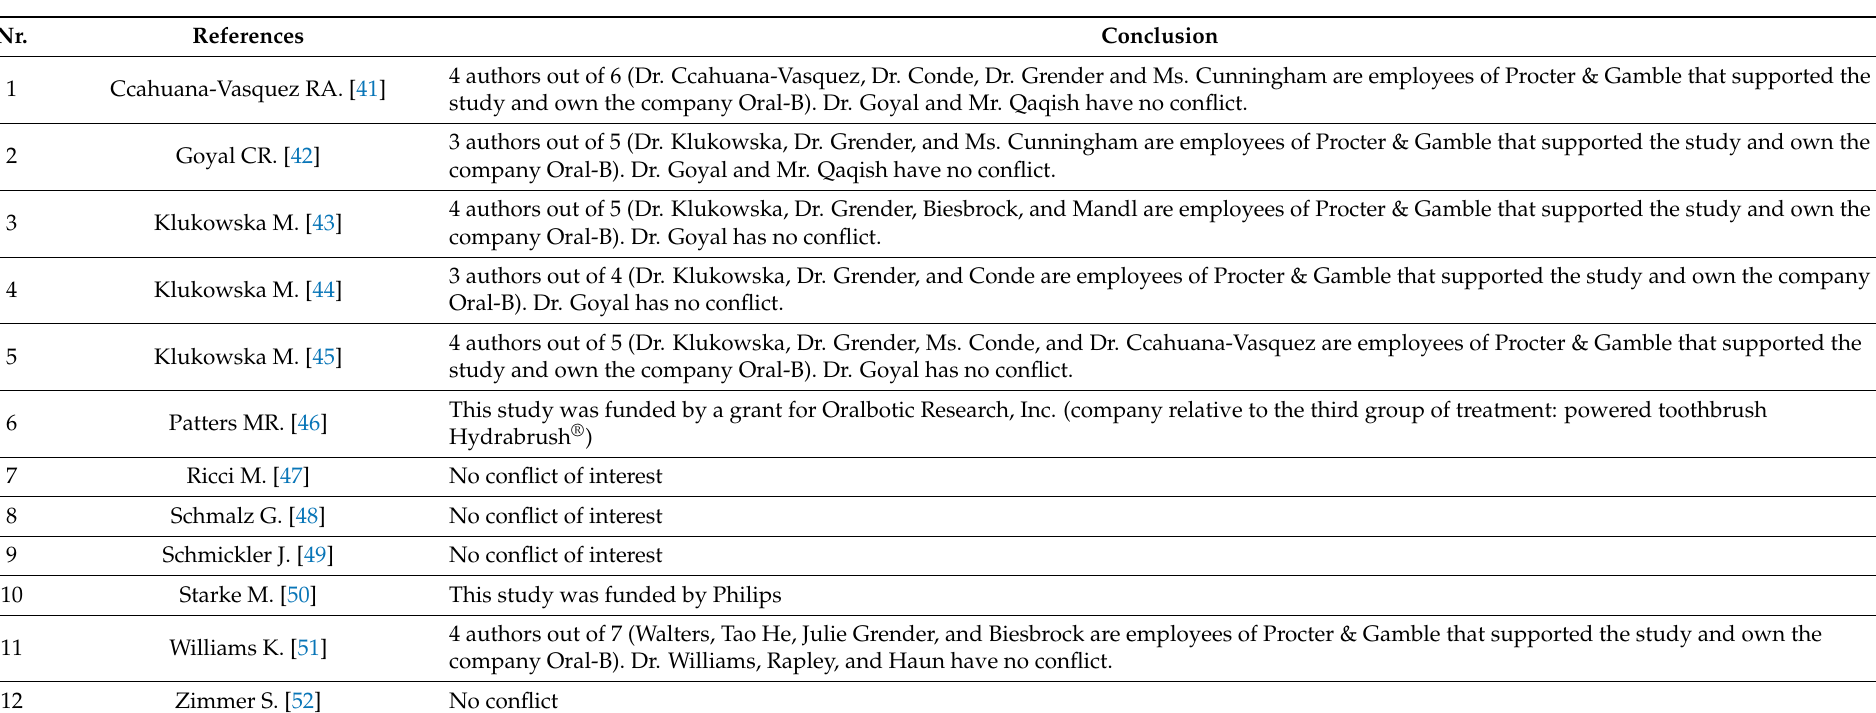
Table 4. Conflicts of interest for each included